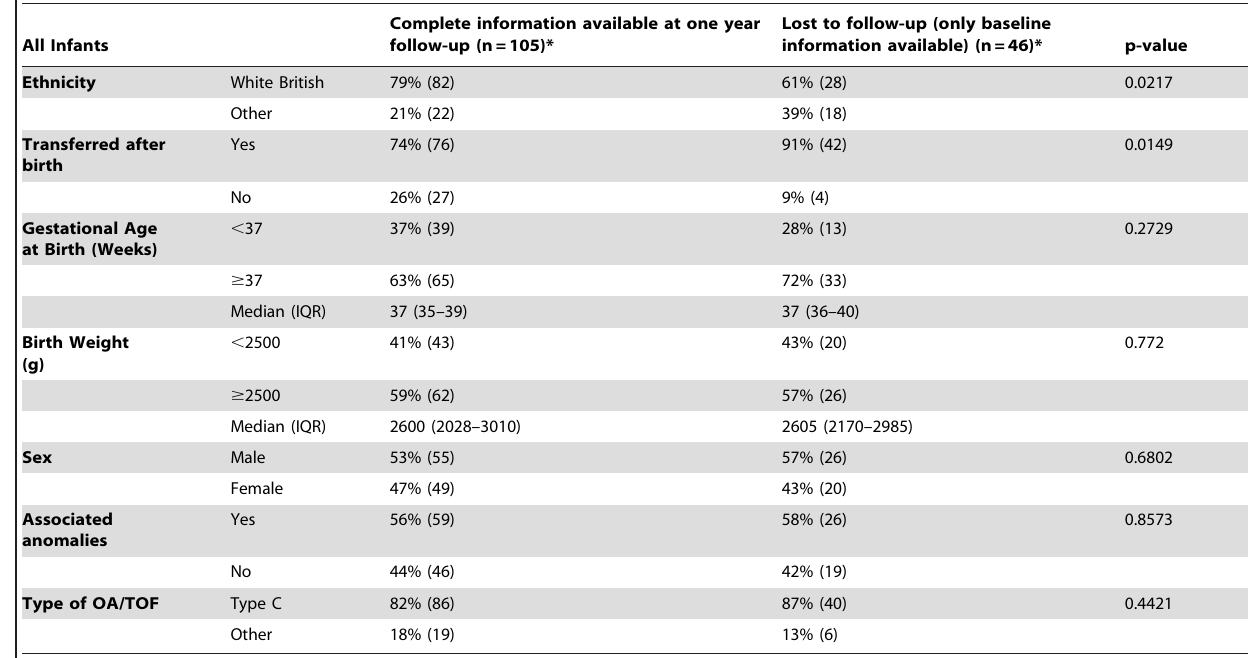
Table 1. Key characteristics of infants with complete follow-up information and those who have been lost to follow-up - all infants.